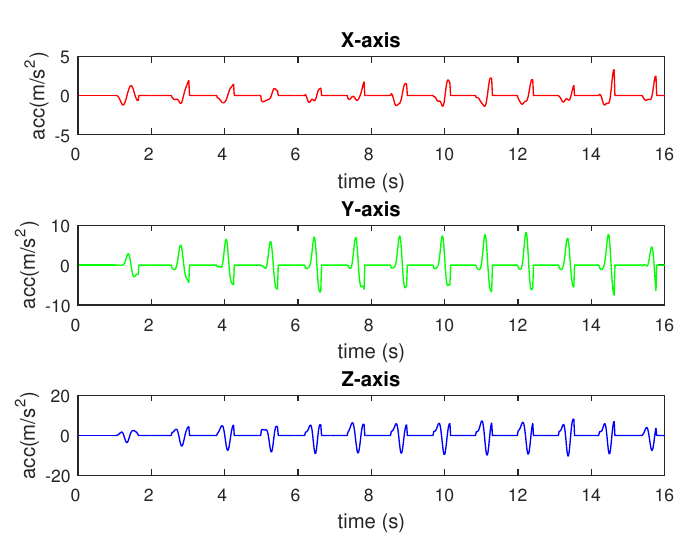
Figure 7. Original acceleration data.